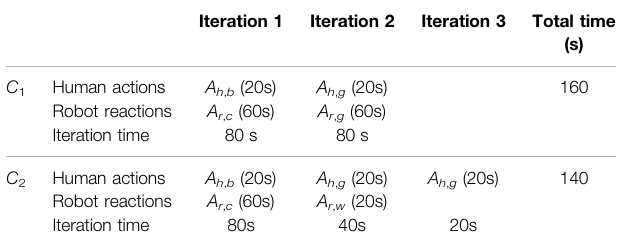
TABLE 3 | The adaptation of time calculation from C 2 to C 1 for the resolution of one scenario of puzzle two. Iteration 1 Iteration 2 Iteration